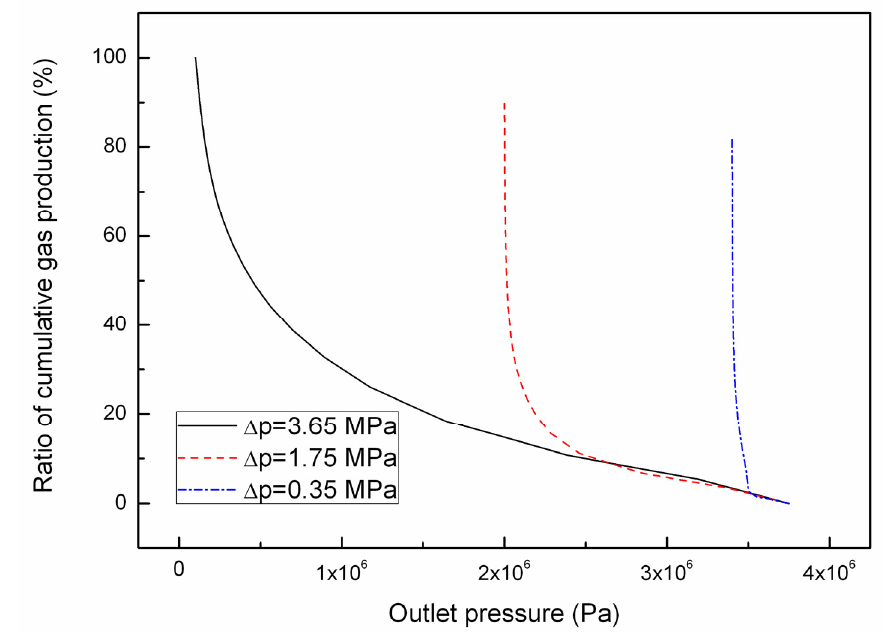
Figure 3. The relationship between the percentage of cumulative gas production and outlet pressure for different depressurizing